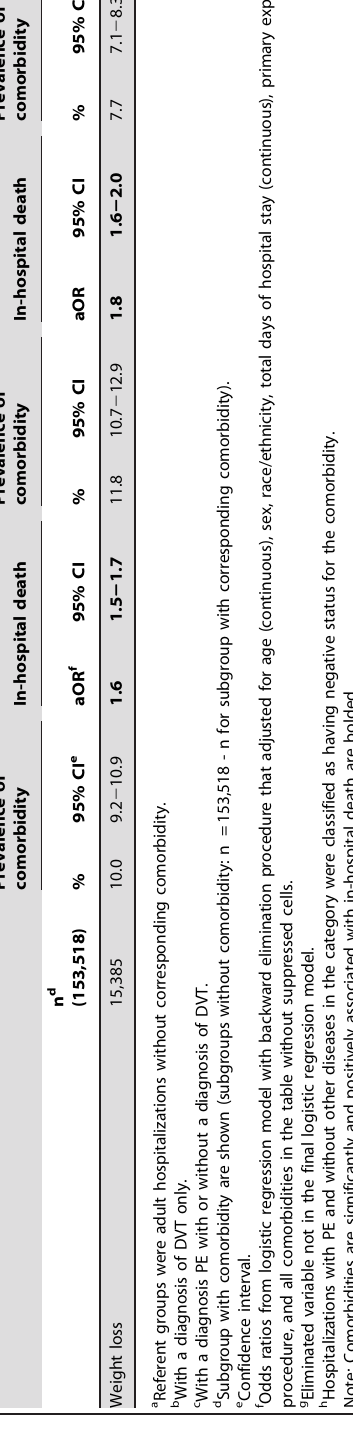
disorders also was associated positively and independently with (Table 2). The distribution patterns of the prevalence for having each of the 13 comorbidities in hospitalizations were similar across the three groups of hospitalizations with VTE, DVT, or PE and ranged from 1.4% for lymphoma to 31.9% for fluid and electrolyte disorder (Table 2). The c-statistic values that obtained from adjusted logistic regression and the ROC models ranged from 0.776 to 0.802. Whereas the c-statistic value obtained from logistic regression models with significant comorbidities suggested an excellent predictive accuracy for in-hospital death among hospi- talizations with DVT, the values generally indicated an acceptable predictive accuracy for in-hospital death among hospitalizations with VTE and among hospitalizations with DVT (full model) or PE (Table 3).